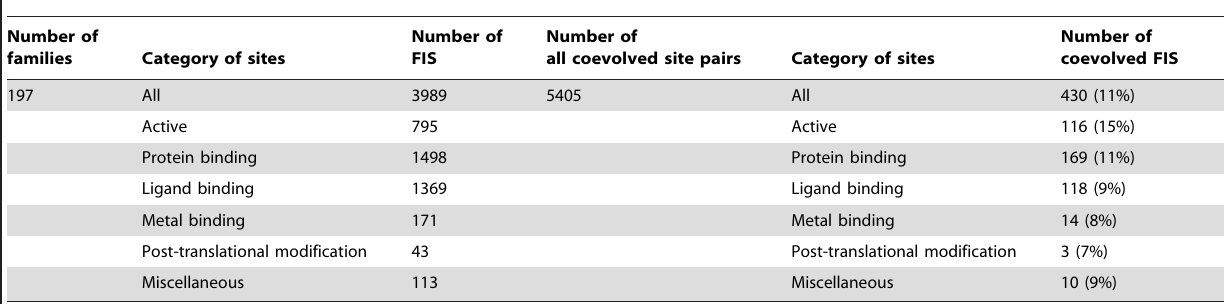
Table 2. Coevolution of functionally important sites (FIS).